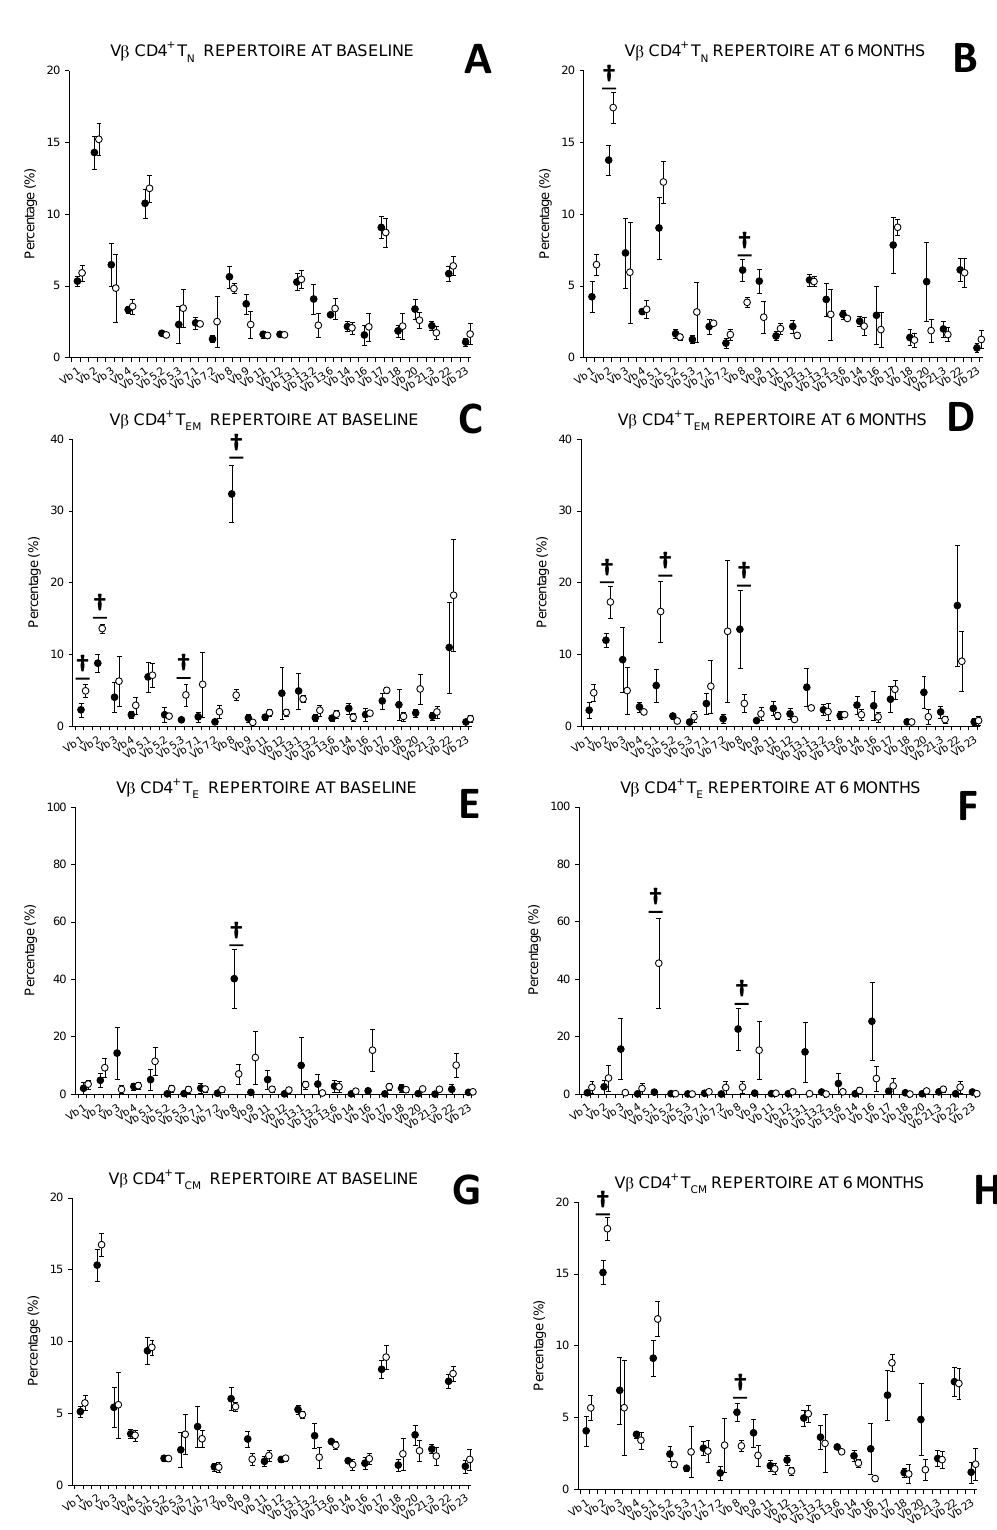
Figure 6. Panels A – H represents the TCR V β distribution of CD4 + T lymphocyte subsets in a responder and non-responder RA patients. Note . Data represent the TCR V β distribution of naïve ( T N ), effector memory (T EM ), effector (T E ) and central memory (T CM ) CD4 + T cells from ( )responders and ( ) non-responders at up to 6 months of MTX treatment. All values are ) expressed as percentages ± S.E.M. †, p <0.05 for responders vs. non-responders.